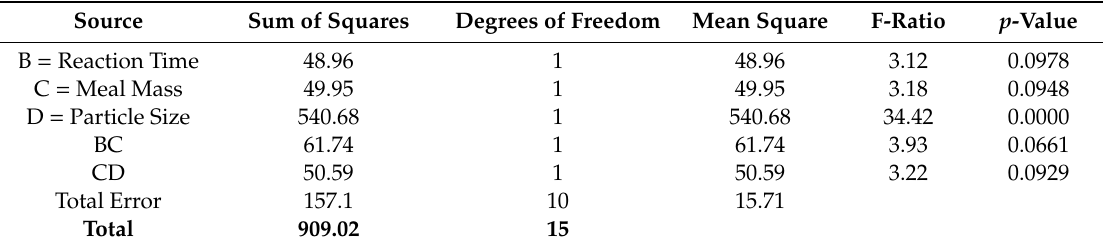
Table 3. ANOVA results for the screening experiment excluding reaction temperature from the sources of variation.